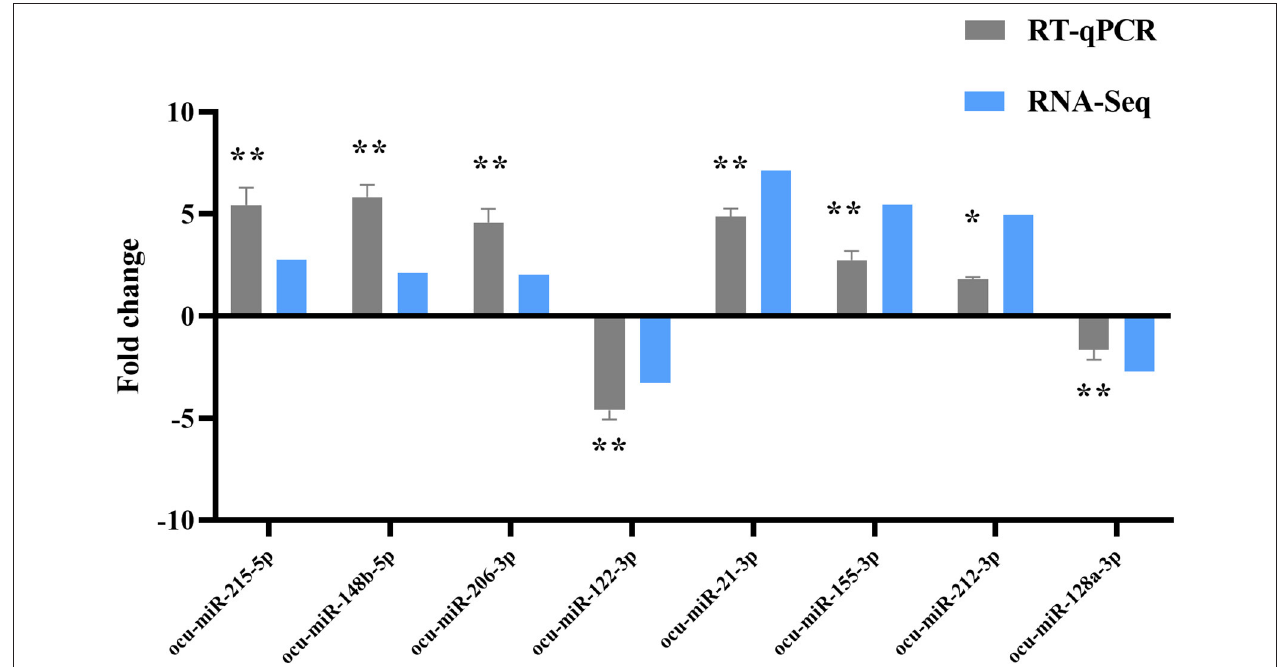
FIGURE 7 | RT-qPCR validation of DE-miRNAs. Compared with the P0, * P < 0.05, ** P < 0.01.